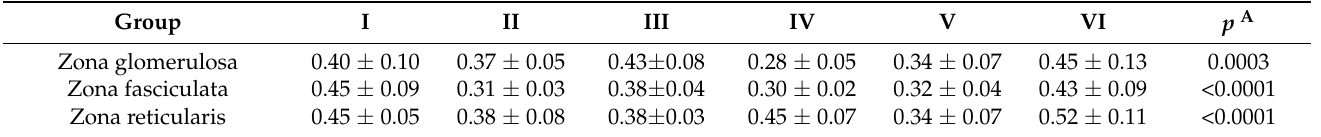
Table 3. Mean optical density of Masson’s trichrome staining by group—measurement of the extent of fibrosis.